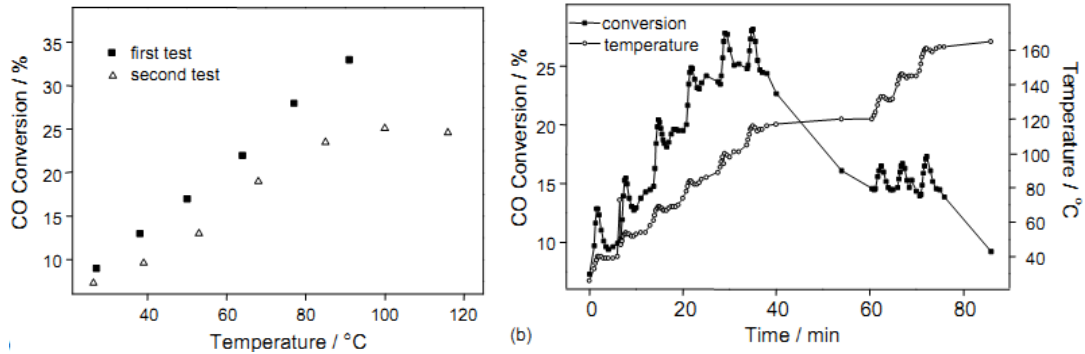
Figure 5. Catalytic activity of Au/SBA-15 ( a ) CO conversion plotted against time for the first and second run and ( b ) CO conversion and temperature plotted against time for the second run. Reaction conditions: 1% CO in air, flow rate: 67 mL min − 1 . Reproduced with permission from [35]. Copyright 2002 Verlag GmbH & Co. KGaA, Weinheim.